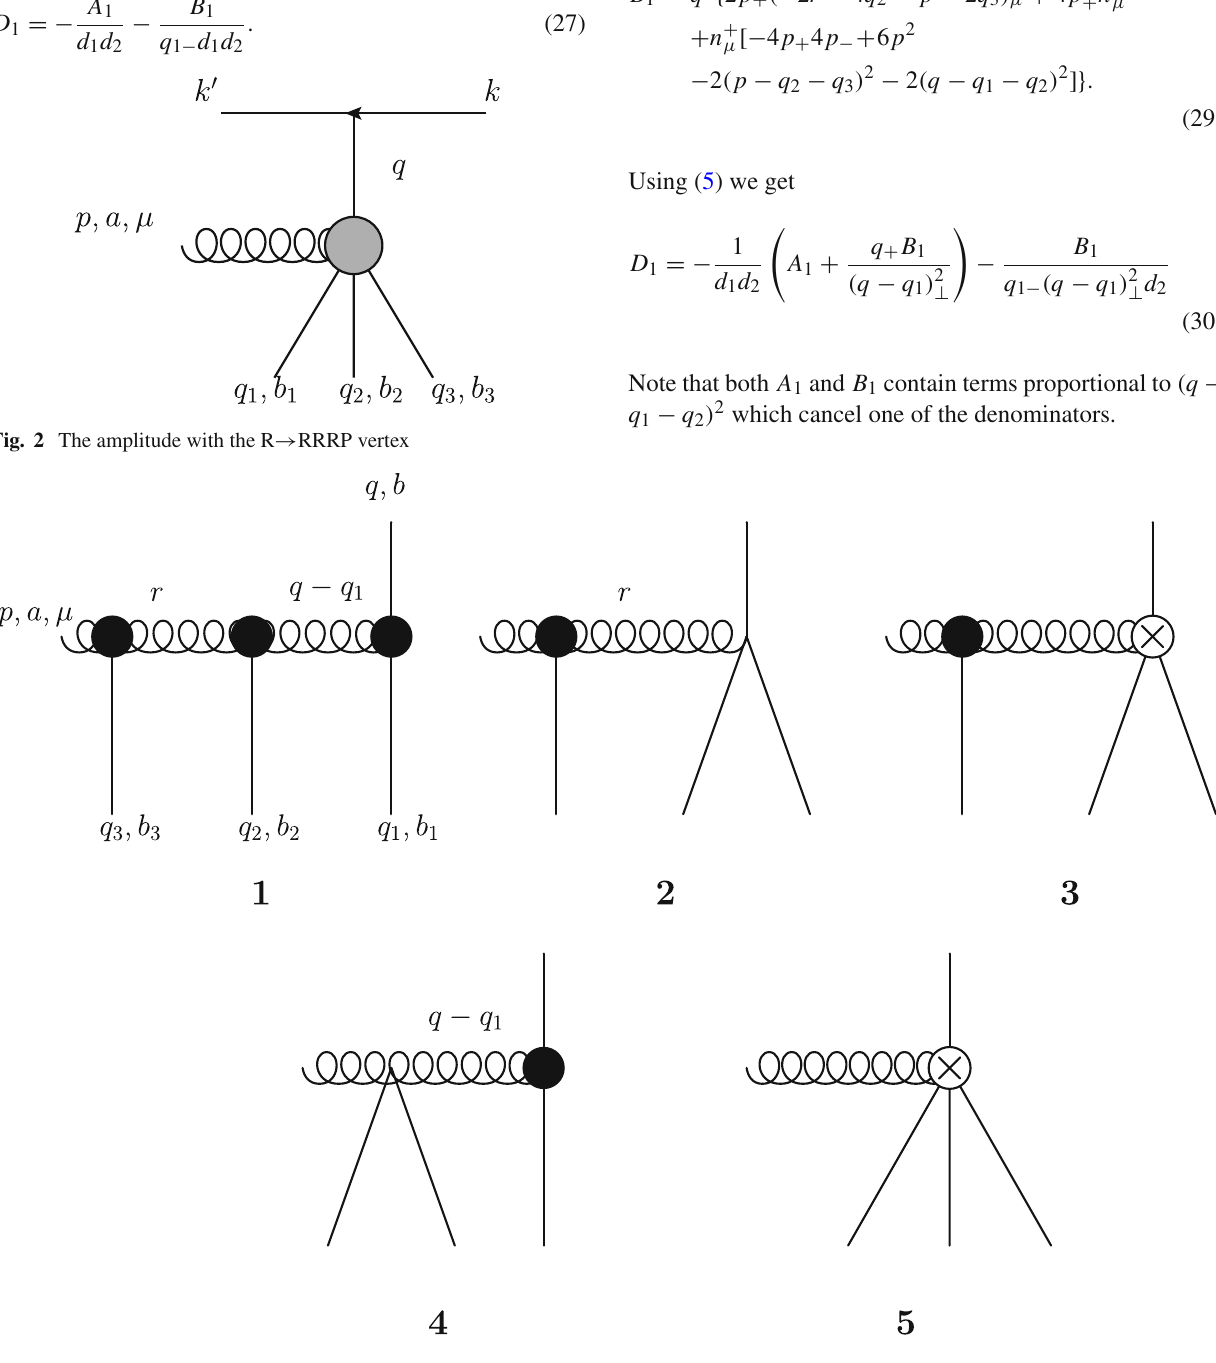
Fig. 3 Diagrams for the R → RRRP